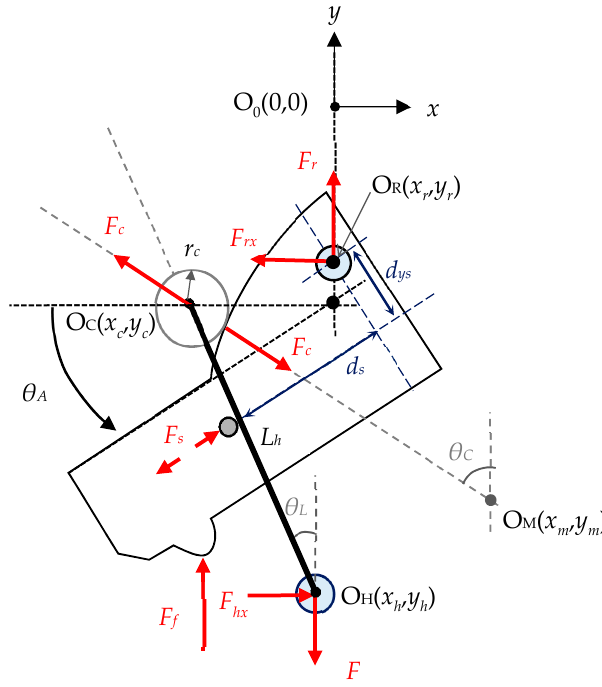
Figure 3. Free body diagram of link C and the swingarm.